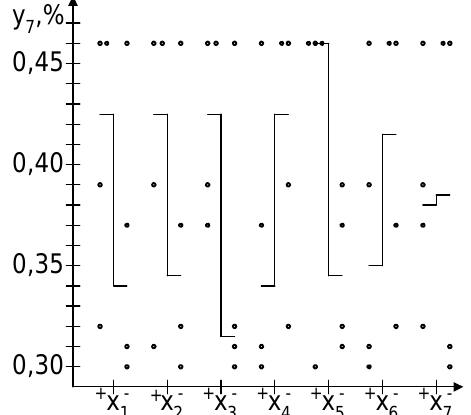
Fig. 2. Diagram of scattering of the influence of quantitative factors on mass loss during